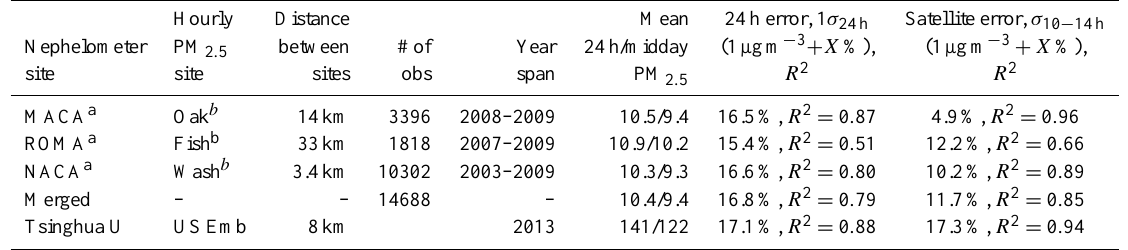
Table A1. Comparison of hourly PM 2 . 5 measured at a site versus predicted using Eq. (1) and a nephelometer at different sites. For all sites a RH < 80% cut-off was used to filter humid data.